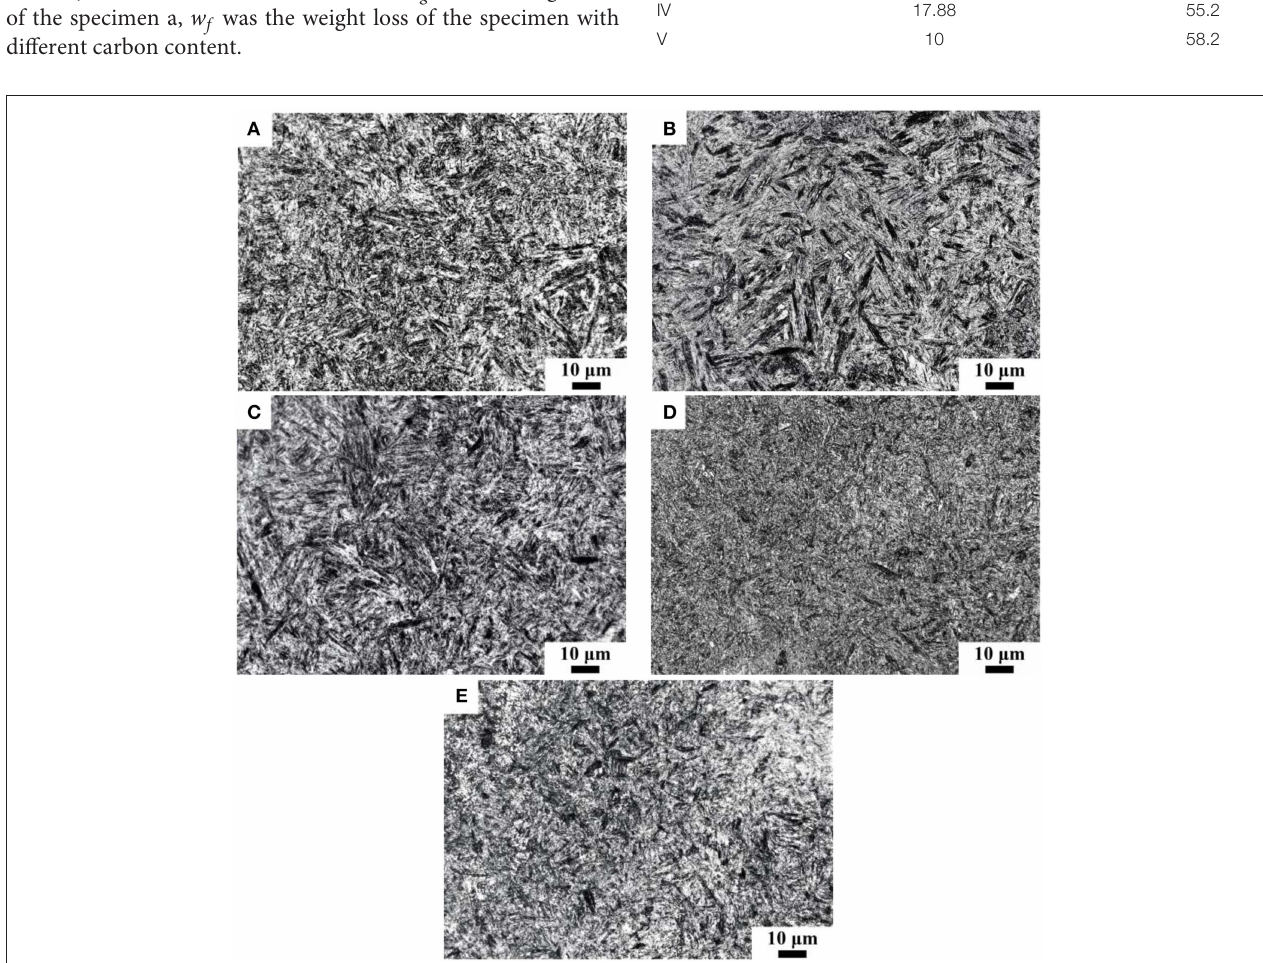
FIGURE 3 | Microstructure of LAWRCS with different carbon contents after heat treatment (A) 0.32 wt%, (B) 0.35 wt%, (C) 0.40 wt%, (D) 0.46 wt%, (E) 0.55 wt%.